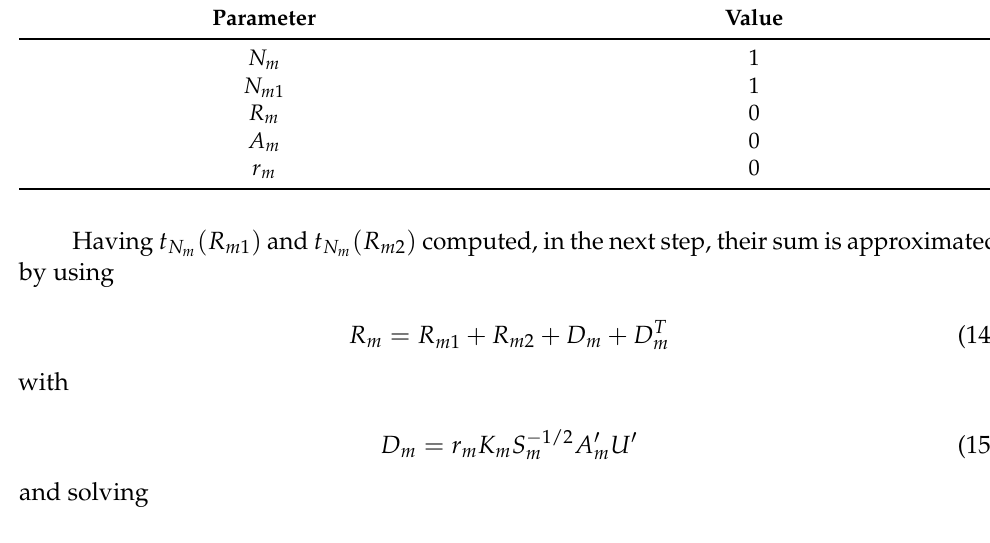
Table 2. Initial values for KIPL integrity algorithm (values based on [37]).